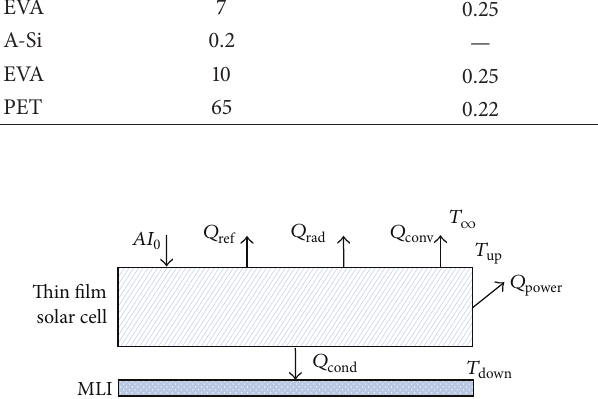
Figure 4: Mechanism of heat transfer of the flexible thin-film solar cell.